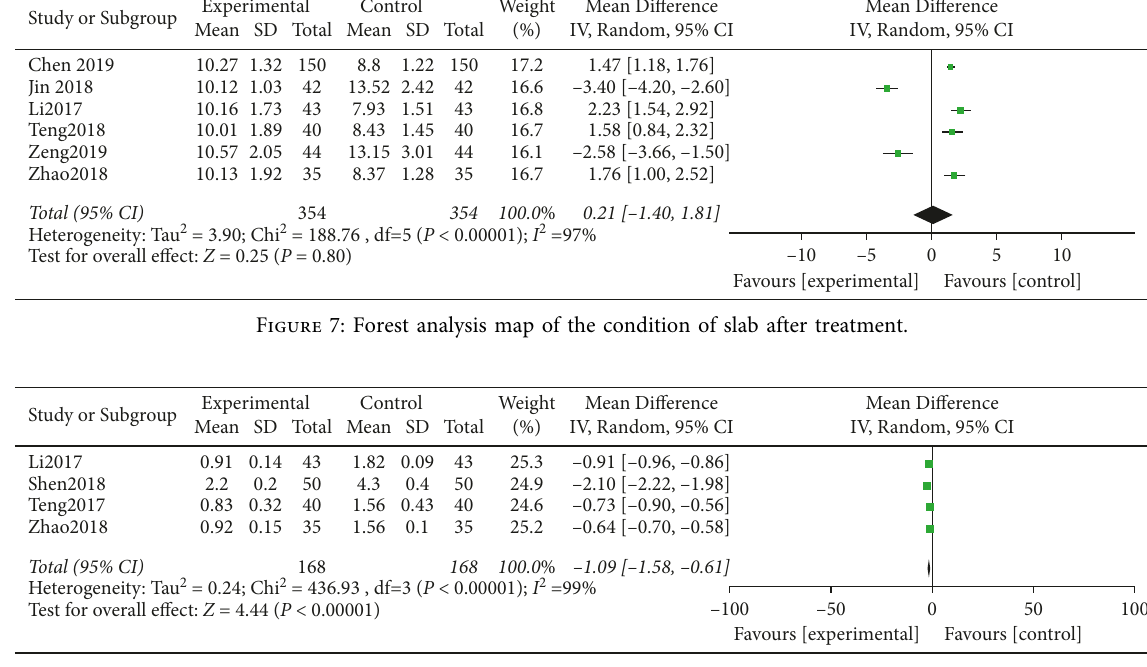
Figure 8: Forest analysis map of the dry eye symptom